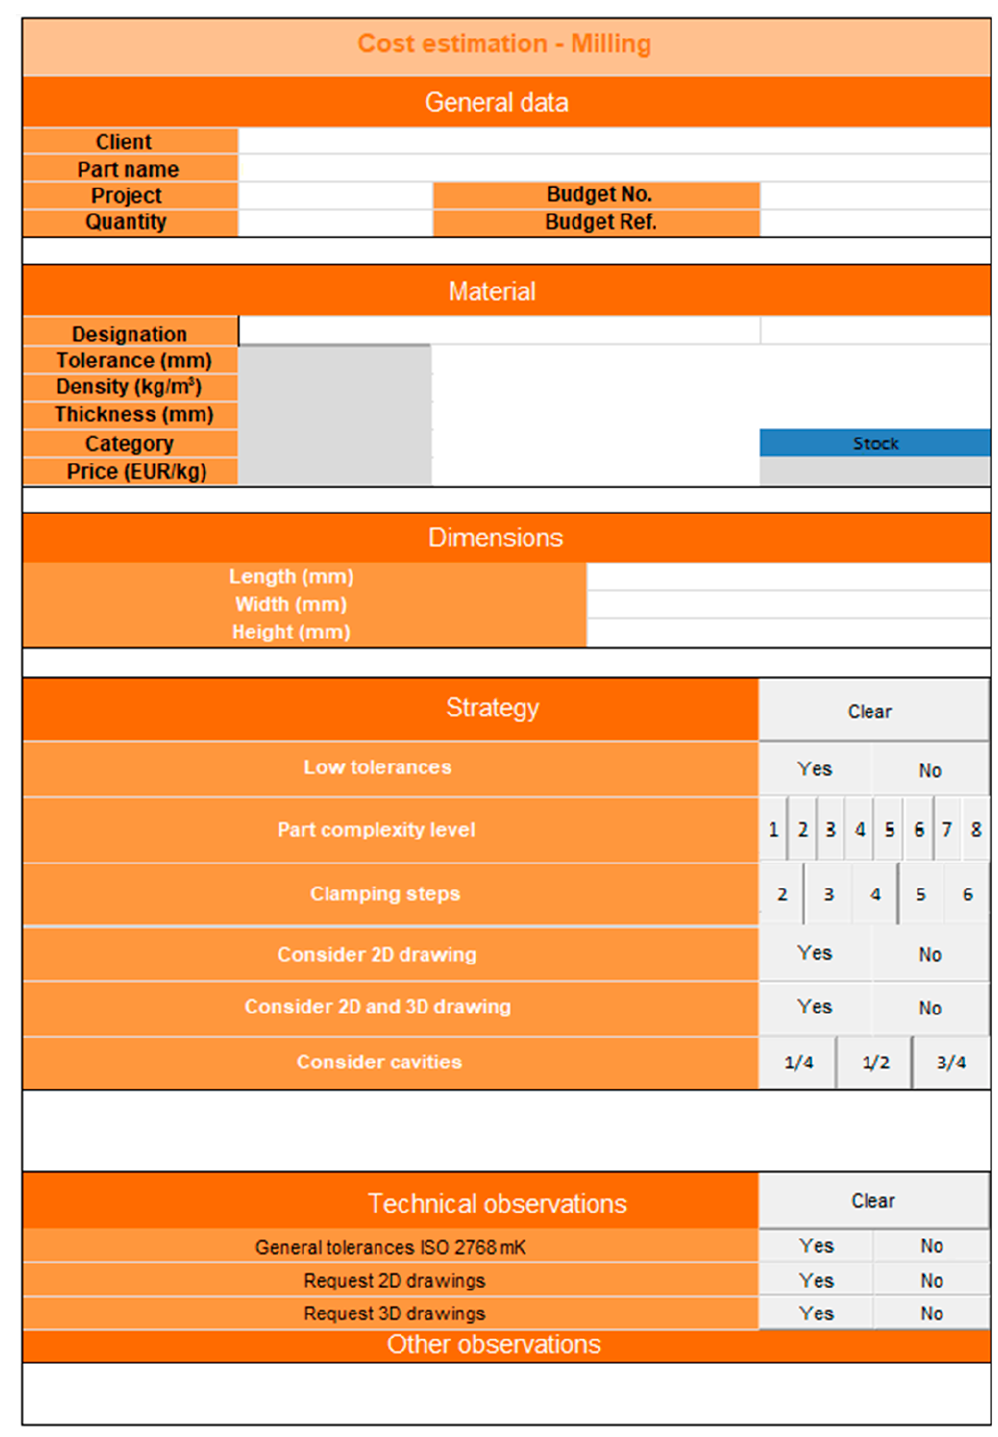
Figure 7. MS Excel ® interface of the developed cost estimation tool.